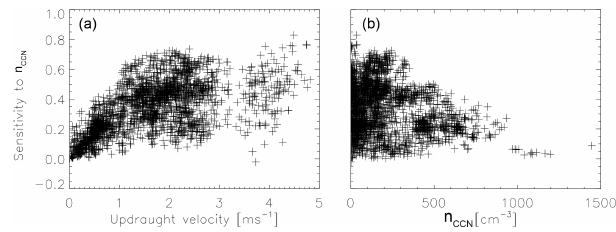
Figure 15. The sensitivity of the modelled droplet number to the up- draught velocity (corrected by a factor of 0.25, following Hammer et al. 2015) (a) and to the number of particles larger than 80nm (b) .